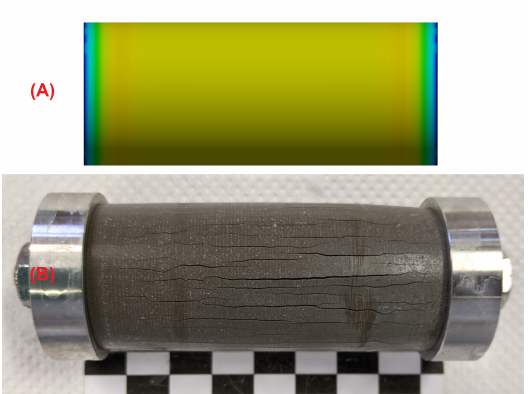
Figure 13. Modelled stress distribution (( A ), finite element model, first main tension) in the undamaged inner core of a hollow cylinder ( l = 70mm) that is exposed to expansion stress ( σ (concave) = 8.0MPa, σ (convex) = 7.2MPa). The tensile strength of the sample’s inner core is exceeded, thus causing the formation of longitudinal macroscopic cracks, as observed in the experi- ments ( B ).